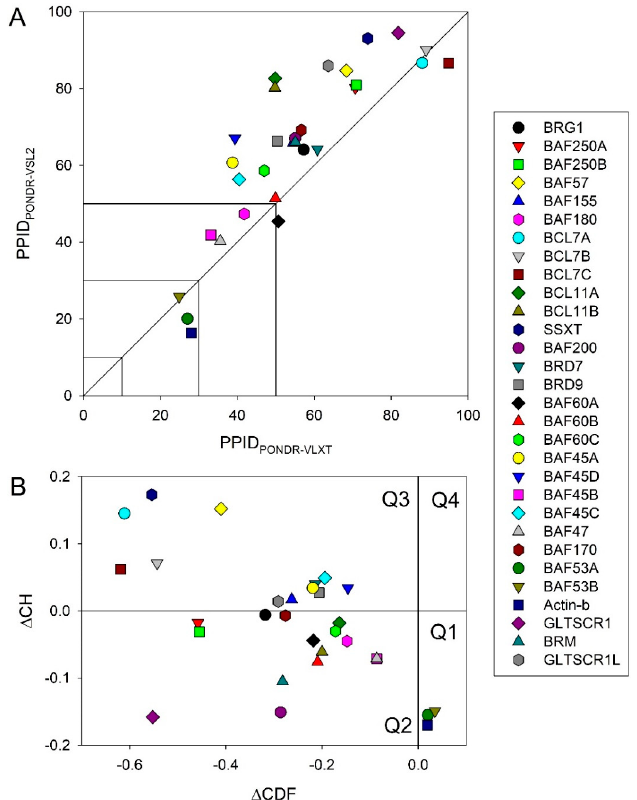
Figure 3. Evaluation of the overall disorder status of 30 subunits of the human BAF complex. ( A ) 2D disorder plot showing presenting the PPID PONDR ® VSL2 vs. PPID PONDR ® VLXT dependence. ( B ) Charge-hydropathy cumulative distribution function (CH-CDF) plot. In this plot, the coordinates of each spot are calculated as a distance of the corresponding protein in the CH-plot from the boundary (Y-coordinate) and an average distance of the respective CDF curve from the CDF boundary (X-coordinate) [109–111].